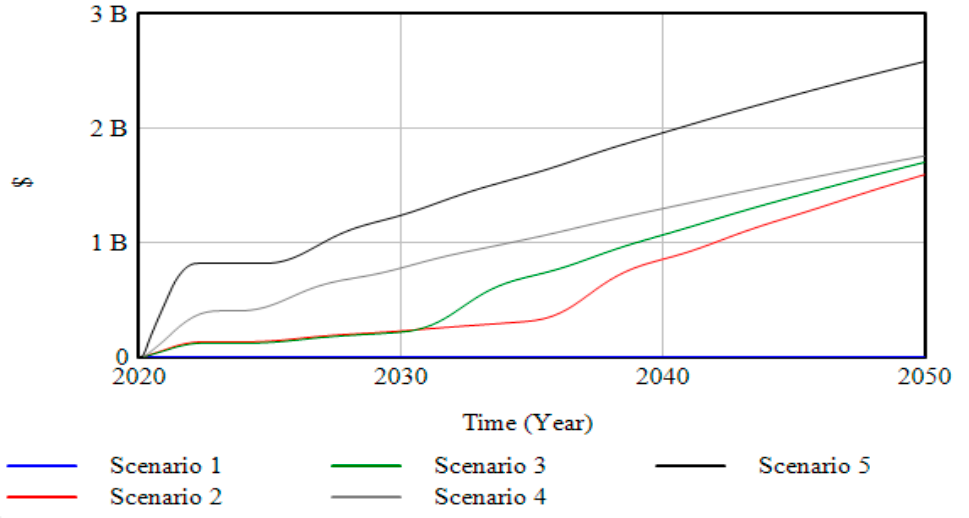
Figure 6. Investments in hydrogen production capacity.